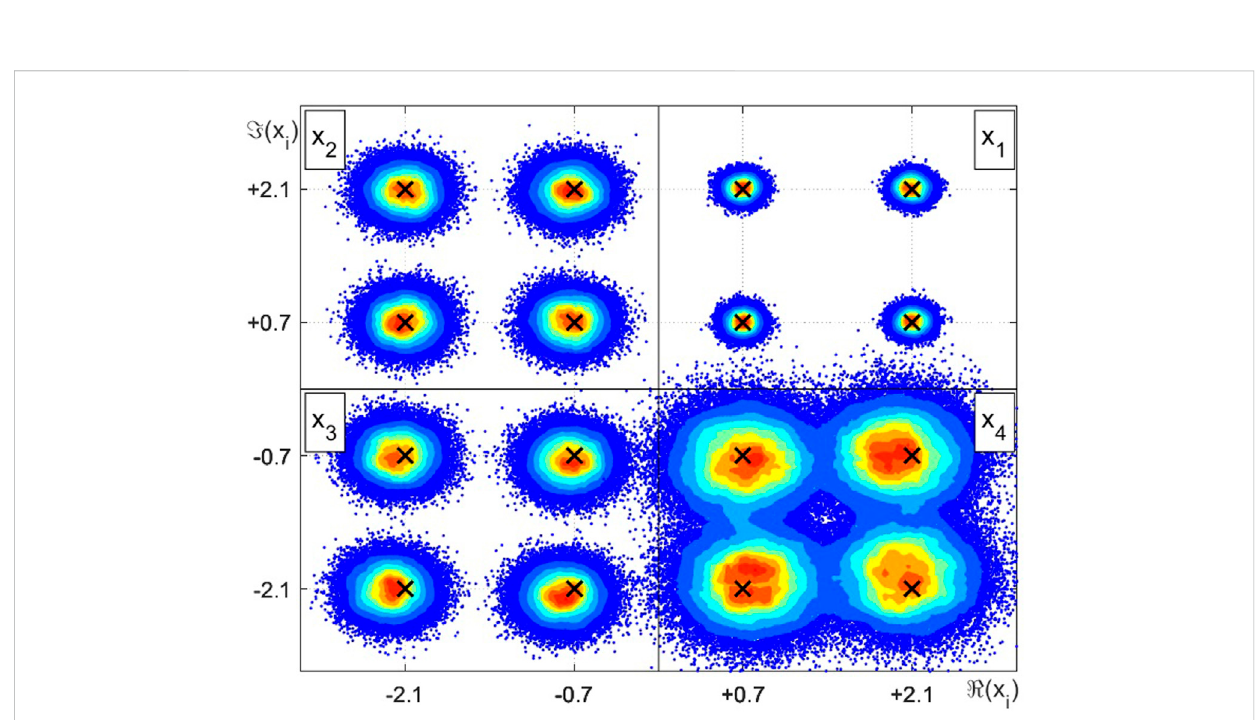
FIGURE 4 Intensity chart for the complex random variables estimation example employing